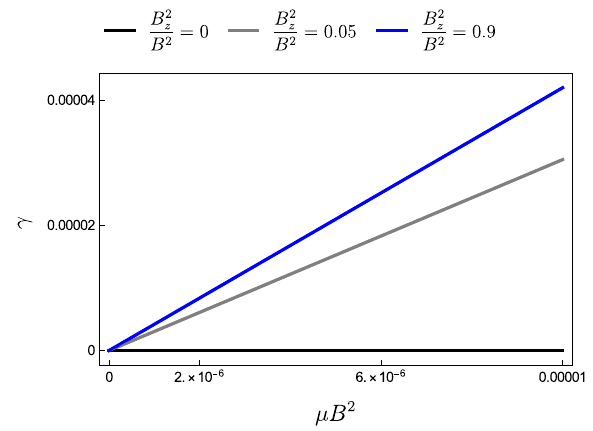
Fig. 3 It is plotted γ , the arising wave electric component in the prop- agating direction, as a function of μ B 2 for different values of B 2 z / B 2